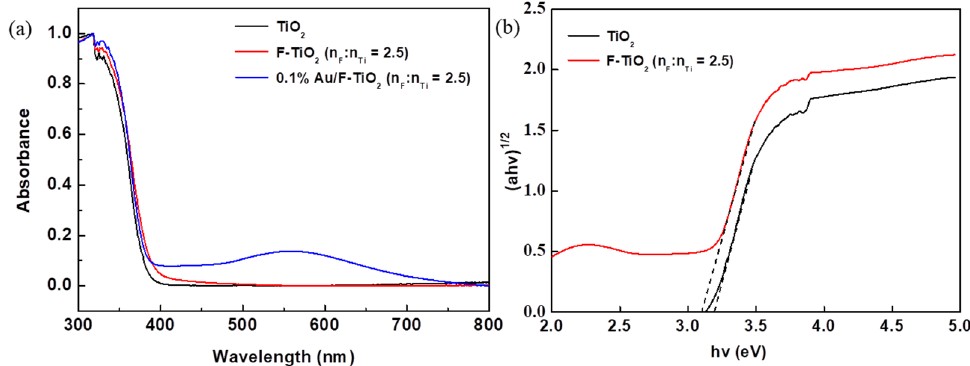
Figure 4. ( a ) UV–Vis absorbance from Kubelka–Munk function of diffuse–reflectance spectra of TiO 2 , F-TiO 2 and 0.1% Au/F-TiO 2 ; ( b ) Tauc plot from ( a ).